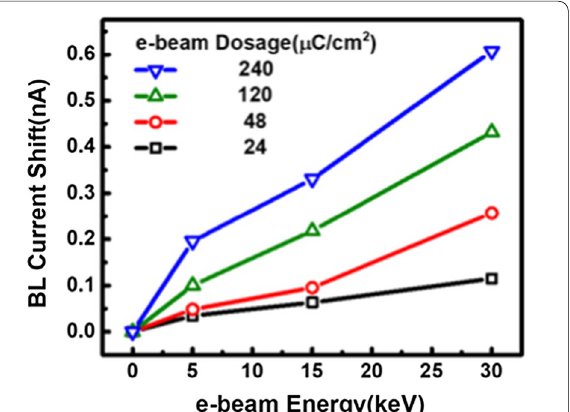
Fig. 5 The distribution of the proposed detectors at the initialized state and that after e‑beam exposure with increasing dosage at a fixed energy level of 30 keV